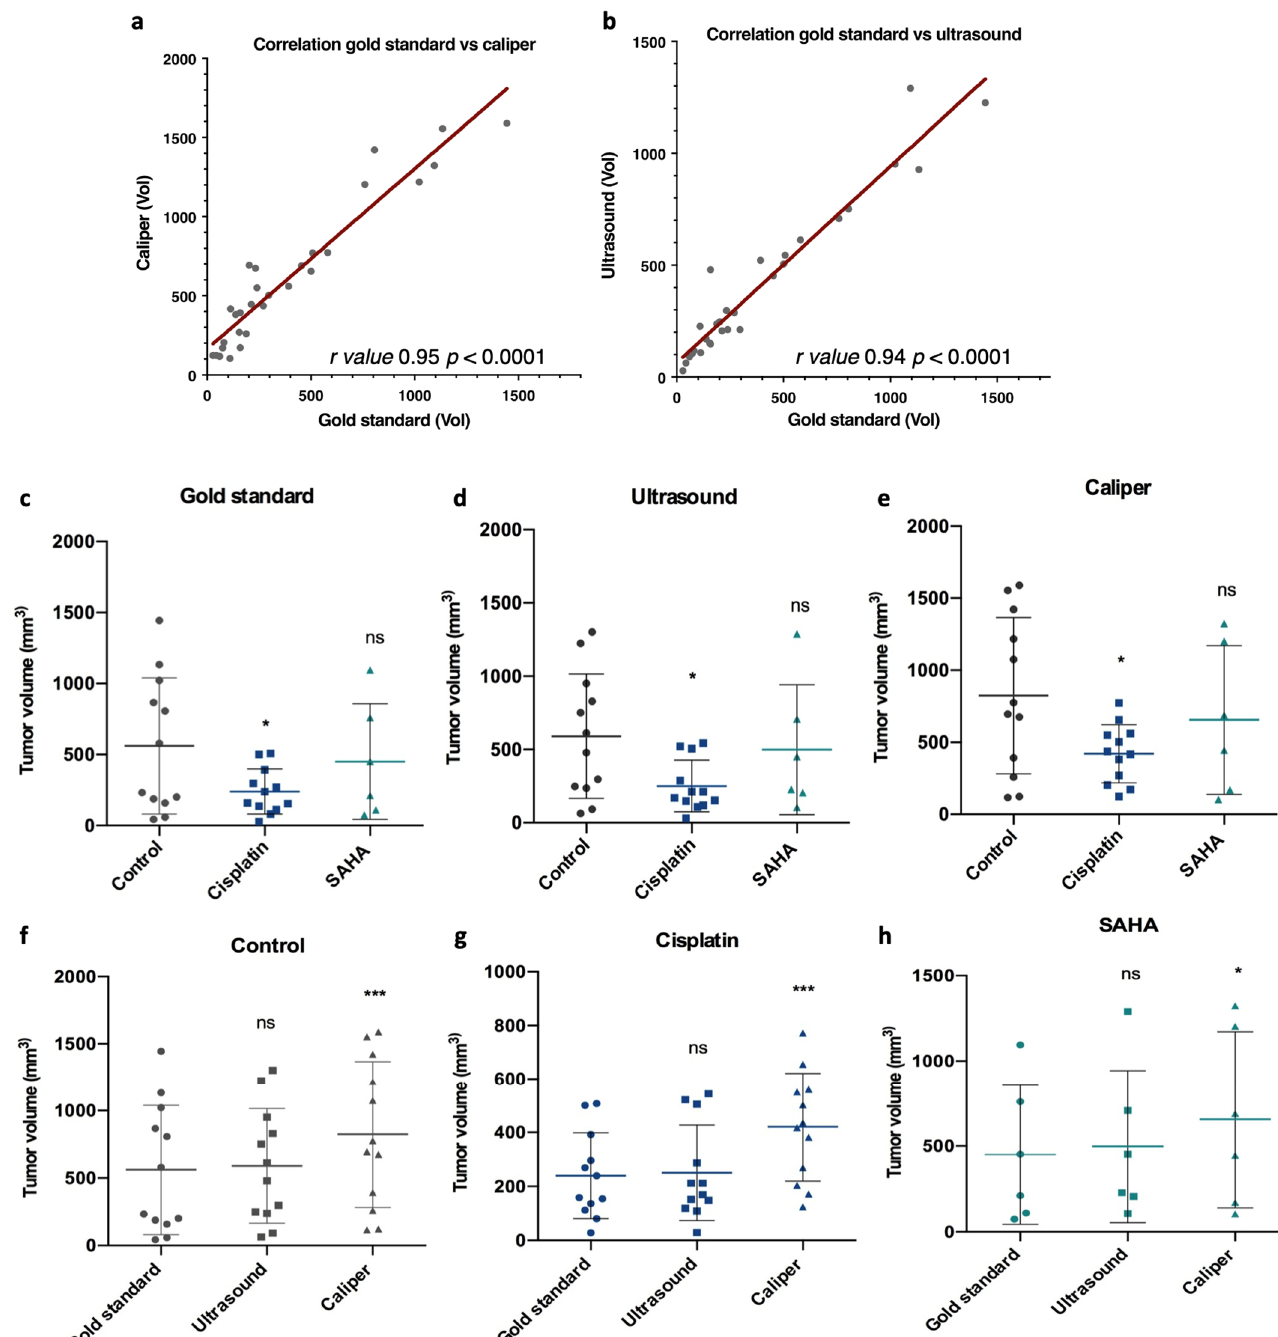
Figure 3. Correlation and comparison of the tumor volume among the gold standard, caliper, and ultrasound measurements, and for each treatment group (control, cisplatin and SAHA). At day 23, final tumor volumes were measured and compared for each measurement method. ( a , b ) Gold standard measurements were correlated with caliper or ultrasound measurements using GraphPad Prism, with r values 0.95 and 0.94, respectively, and with a p value < 0.0001. Then measurements were compared among each treatment group for the gold standard ( c ), caliper ( d ), and ultrasound ( e ), and for each treatment group among the different measurement methods, control ( f ), cisplatin ( g ), and SAHA ( h ). Control n = 12, cisplatin n = 12, SAHA n = 6. Data were subjected to statistical analyses using GraphPad software version 6.0 (ns = not significant, * = p < 0.05, *** = p < 0.001).